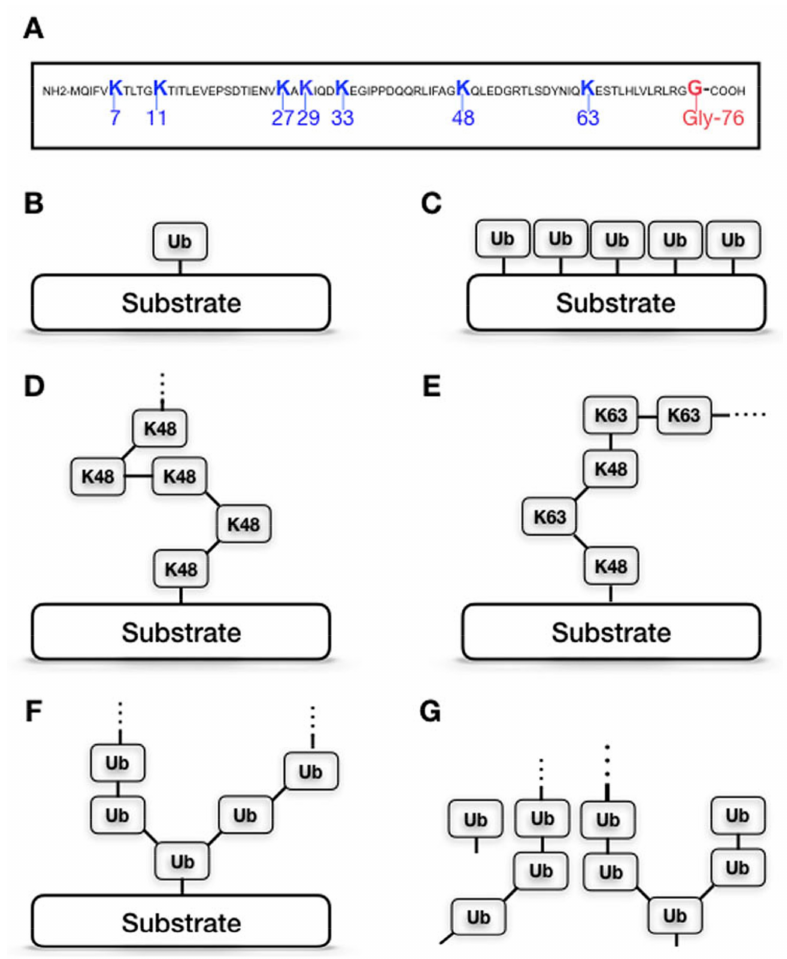
Figure 1. Ubiquitination is a versatile post-translational modification. Ubiquitin has seven internal lysine residues ( A ) which can be used to create different chain topologies. Substrates can be ubiquitinated on more than one residue, by different types of ubiquitination. Substrates can be mono-ubiquitinated ( B ), multimono-ubiquitinated ( C ), poly-ubiquitinated by one or more homogenous ubiquitin chain ( D ), or one or more heterogenous poly-ubiquitin chain ( E ) or by branching poly-ubiquitin chains ( F ). Unanchored Ub chains ( G ) are generated by the deubiquitination of